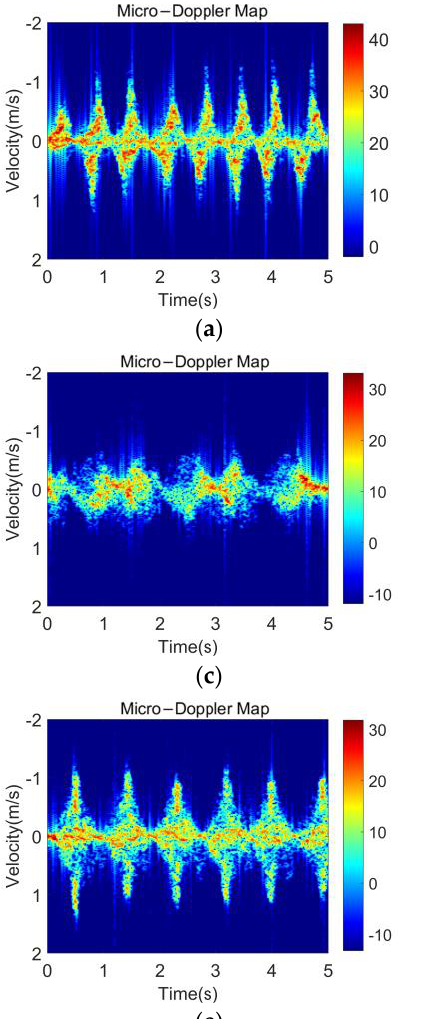
Figure 5. Comparison of the static clutter suppression methods in the walking state: ( a ) frequency response of MTI in the TF domain; ( b ) frequency response of the average cancellation in the TF domain; ( c ) MDM without static clutter suppression; ( d ) MDM after MTI; ( e ) MDM after the average cancellation.